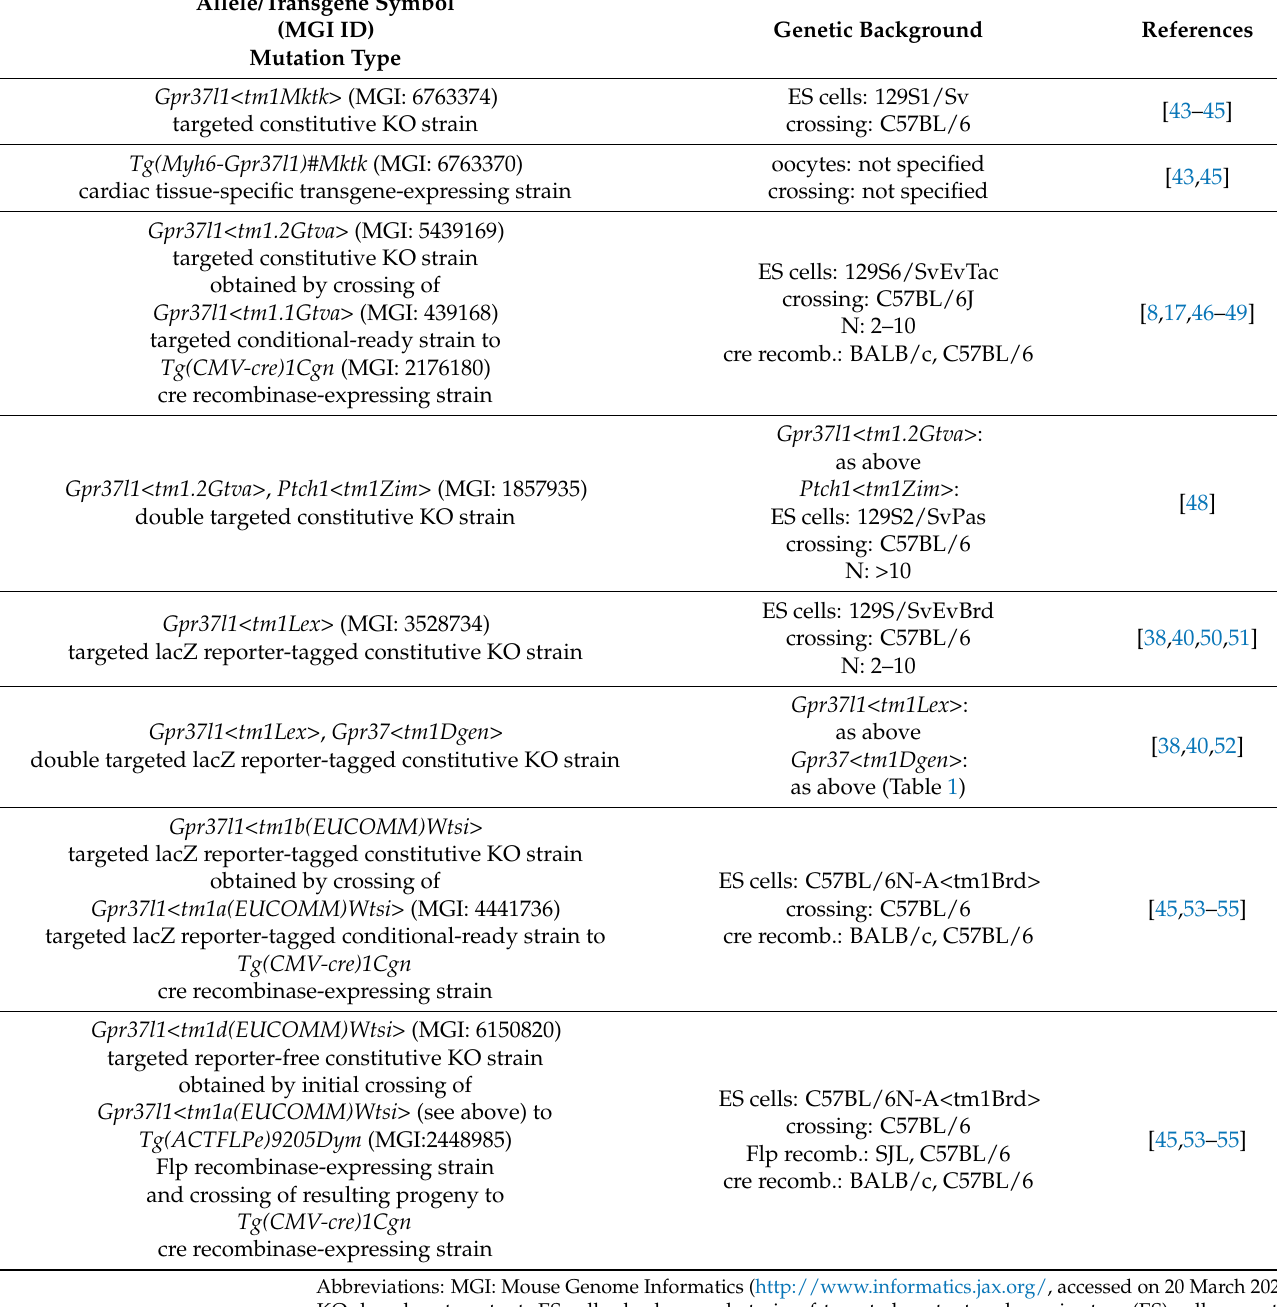
Table 2. Mouse Gpr37l1 mutant strains and Gpr37/Gpr37l1 double mutant strain. Allele/Transgene Symbol